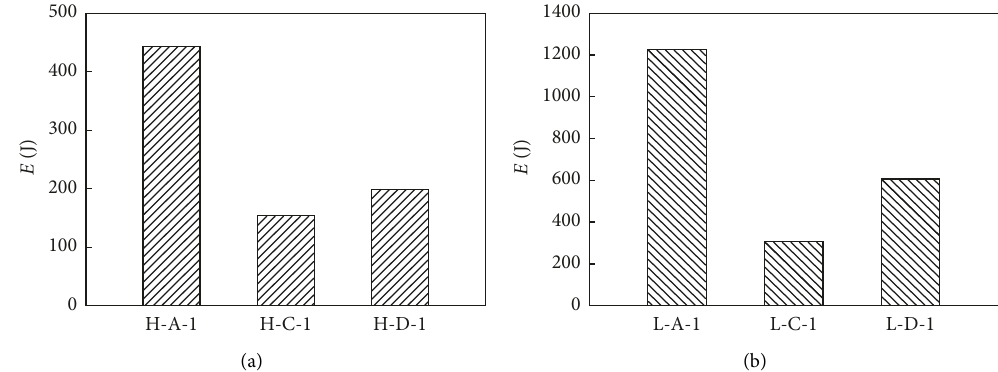
Figure 9: Hysteresis energy of specimens with different thickness. (a) Hysteresis energy of specimens with 6mm thickness. (b) Hysteresis energy of specimens with 12mm thickness.